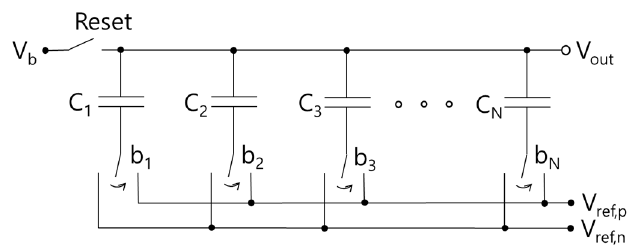
Figure 1. Schematic of the basic C-DAC.